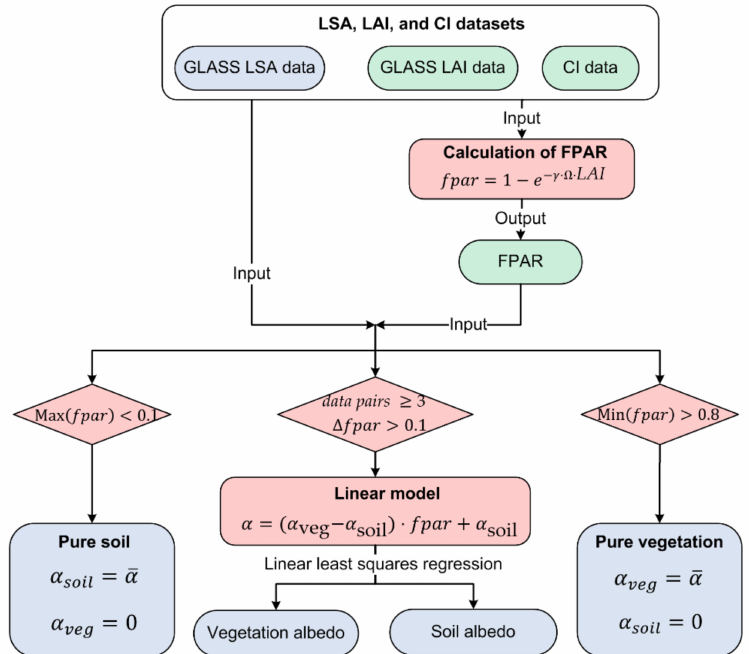
Figure 2. Flowchart for obtaining the albedo of vegetation and soil